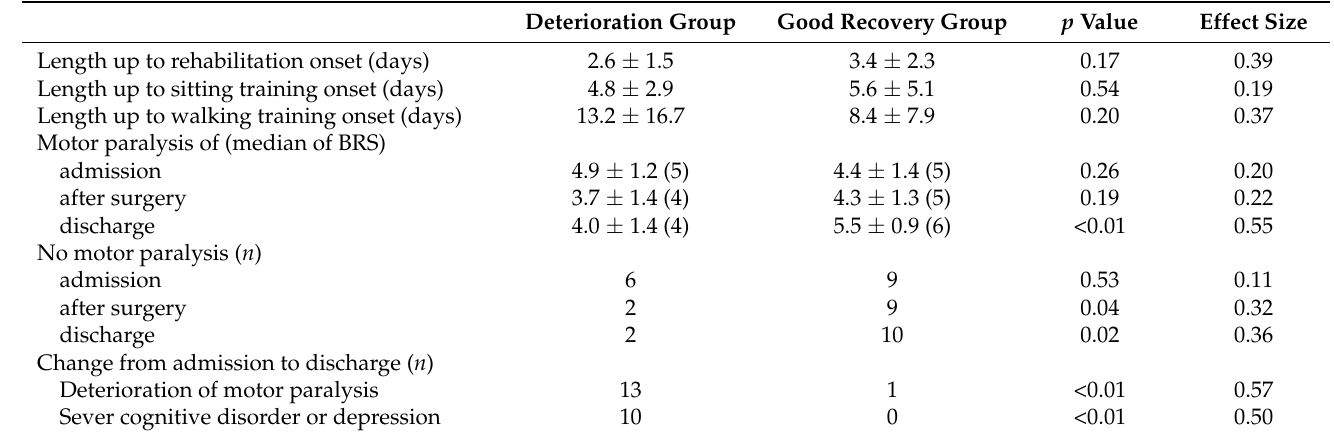
Table 3. Comparison of the deterioration and good recovery groups based on rehabilitation- related factors.